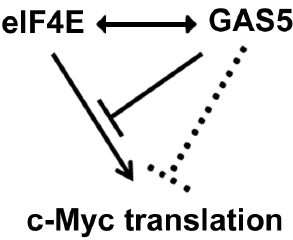
Figure 6. A schematic diagram of the GAS5 and c-Myc translation